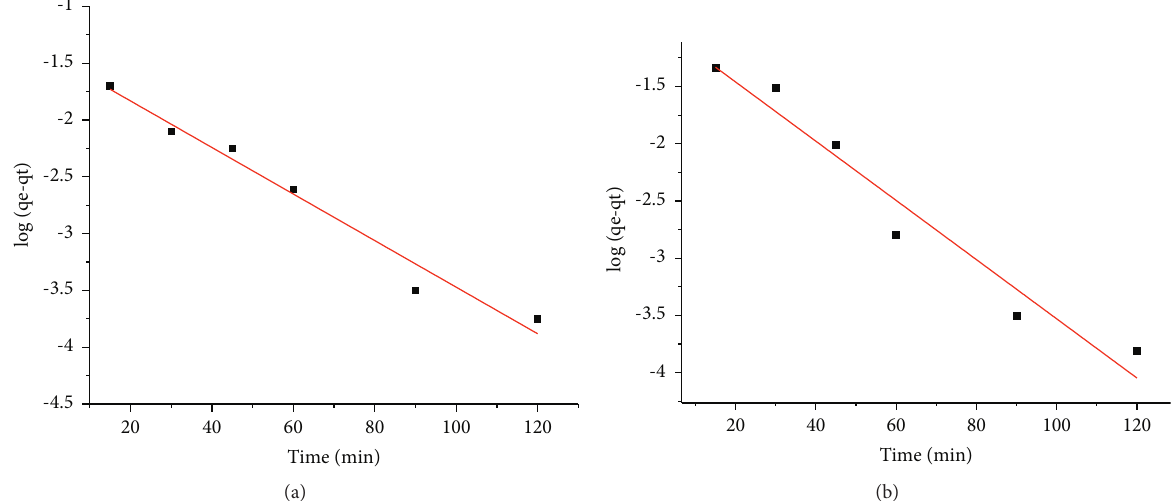
Figure 12: Pseudo-first order kinetic model fitting for activated carbon of corncob (a) and sorghum husk